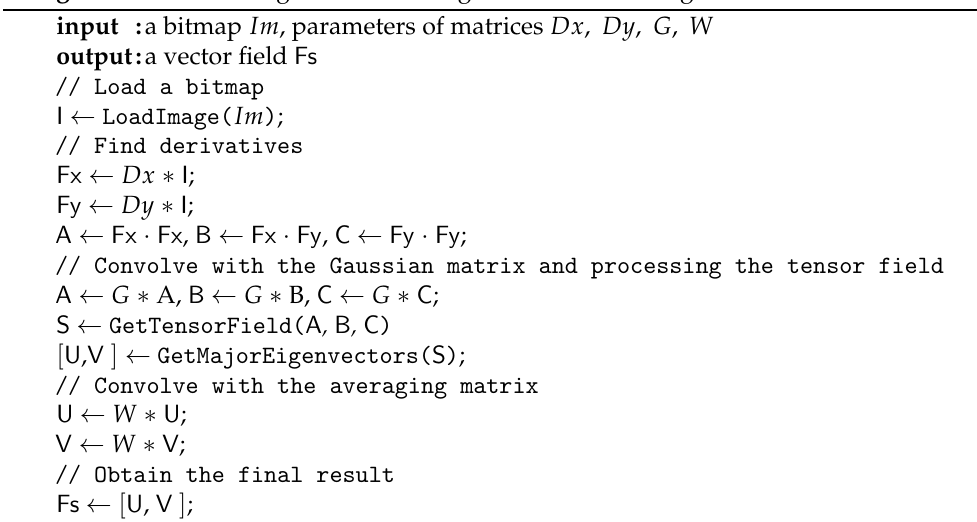
Algorithm 1: Obtaining a smoothed edge field from an